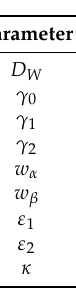
Table 4. List of dimensionless parameter values calculated from the values listed in Table 3 and Equation (22); † being the free